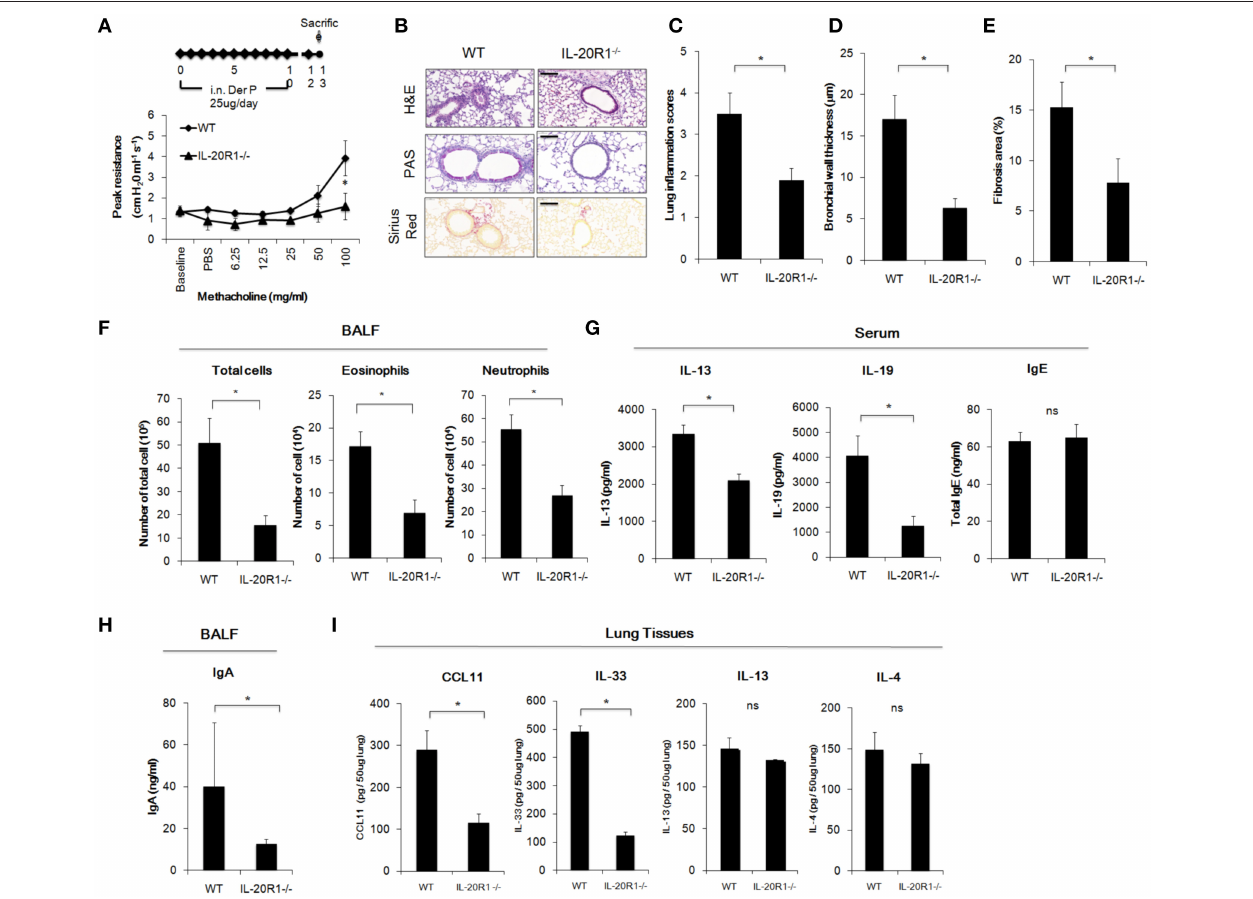
FIGURE 4 | Der p -induced chronic asthma was attenuated in IL-20R1 − / − mice. Wild-type C57BL/6 and IL-20R1 − / − mice ( n = 6 in each group) were intranasally (i.n.) challenged with Der p extract (25 µ g/mouse/day) for 10 days to induce asthma. (A) Airway hyperresponsiveness (AHR) was analyzed on day 13. IL-20R1 − / − mice had lower peak airway resistance with increasing doses of methacholine than did wild-type mice. (B) Histopathology assessments for lung inflammation, airway wall thickness by Hematoxylin and Eosin (H&E) and PAS staining. Degree of collagen deposition was evaluated by Sirius Red staining. Bars represented 50 µ m. (C) Quantification of lung inflammation scores. (D) Quantification of bronchial wall thickness. (E) Quantification of Fibrosis area. (F) The number of infiltrated immune cells in mouse bronchoalveolar lavage fluid (BALF). (G) Serum IL-13, IL-19, and IgE levels. (H) BALF IgA levels. (I) Inflammatory cytokine levels (CCL11, IL-33, IL-13, and IL-4) in the lung tissues. * P < 0.05 by t -test. ns, not